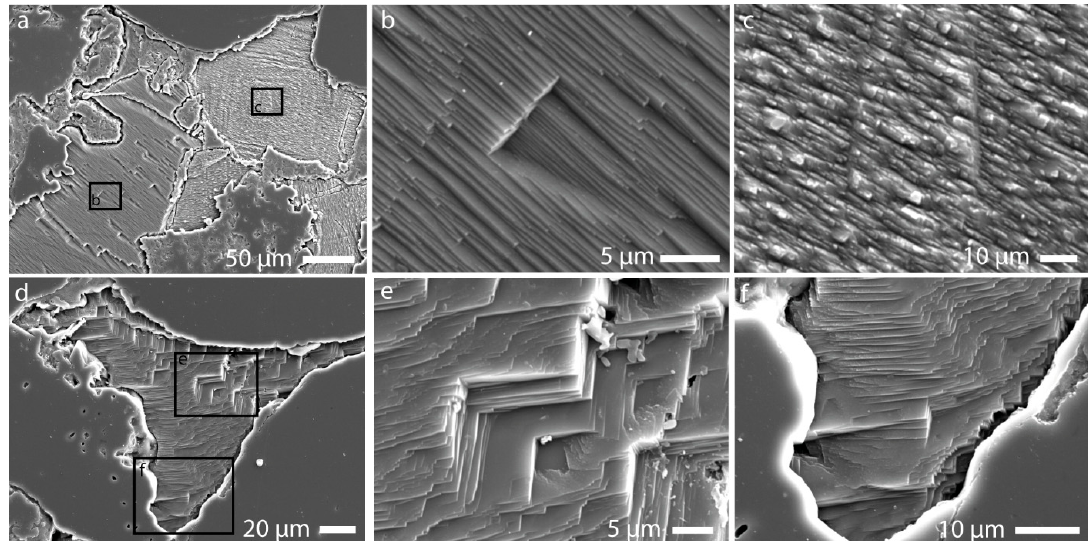
Figure 2. Secondary electron microscopy images of the calcite cement patches of the sandstone after dissolution (2 mmol Na 2 CO 3 , 32 h, room T ): ( a ) Calcite patch showing two distinct dissolution microstructures; ( b ) detail of surface showing striated surface microstructure; ( c ) detail of hill-and-valley surface microstructure; ( d ) calcite patch showing a single microstructure; ( e ) detail of rhombohedral form of calcite sheets; and ( f ) detail of calcite patch corner showing micron-scale dissolution steps at the edge of the crystal (grain boundary).